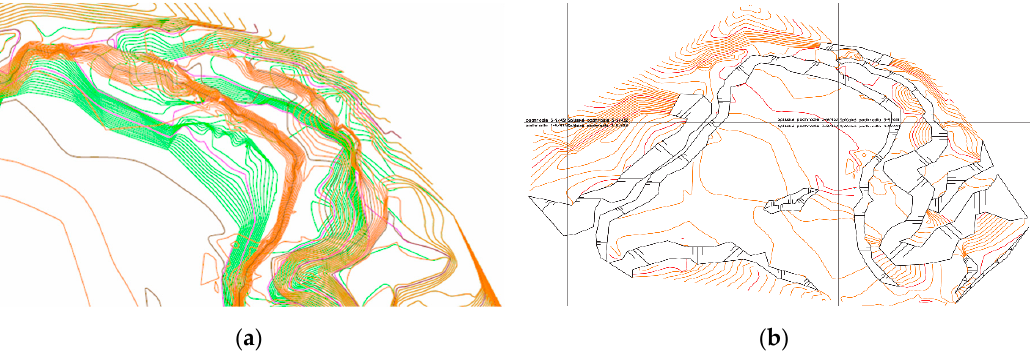
Figure 9. Graphical representation of the extraction process between two periods from GNSS + TS data and the representation of the technical hachures with the contour lines (1 m interval). ( a ) green—day 1; brown—1414. day of observation; ( b ) status at 1414. day of observation.